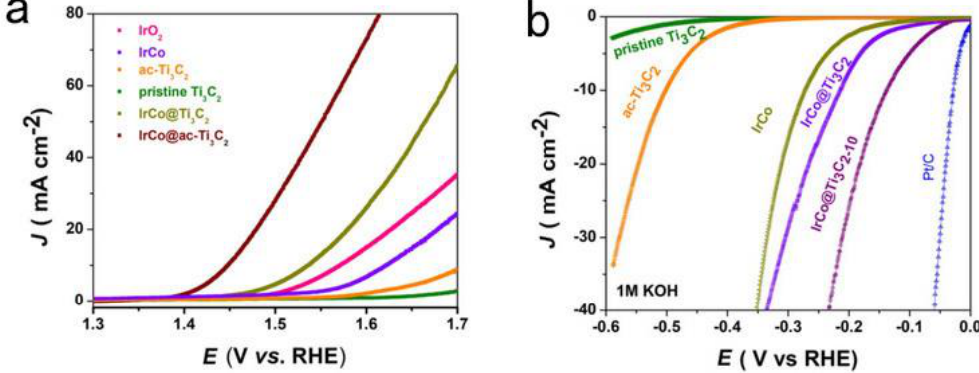
Figure 12. MXene materials have three different formulas (M 2 XT X , M 3 X 2 T X , and M 4 X 3 T X ) and three different structures, including mono-M elements, solid solution double-M elements, and ordered double-M elements. In the ordered double-M elements MXene, one transition metal forms the peripheral layers, while the other occupies the central layer, whereas the solid solution double-M MXene has no sequence like this. Reproduced with permission from [40]. Copyright 2019 Small .